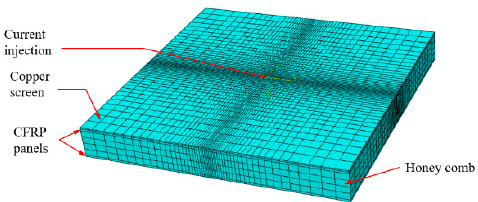
Figure 1. Finite element model diagram. Table 1. Mechanical properties of applied materials at 25 °C.